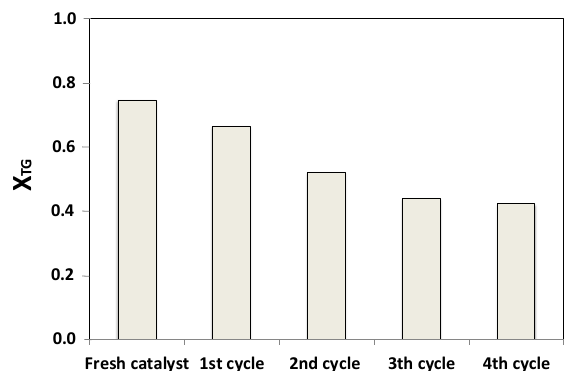
Figure 8. Triglycerides conversion (X TG ) obtained after 8 h of reaction during the number of reuse cycles indicated for the catalyst s-Mo (8). Reaction conditions: 100 °C, 30 atm, methanol/feedstock molar ratio of 12:1, 2 wt.% catalyst referred to the feedstock mass. Feedstock: refined sunflower oil containing 5 wt.% free oleic acid.